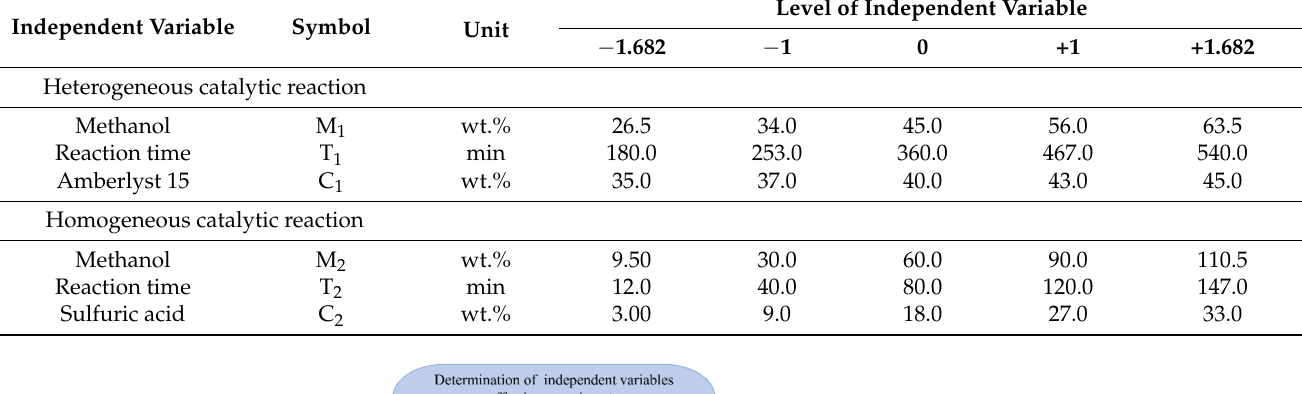
Table 7. Range of independent variables.